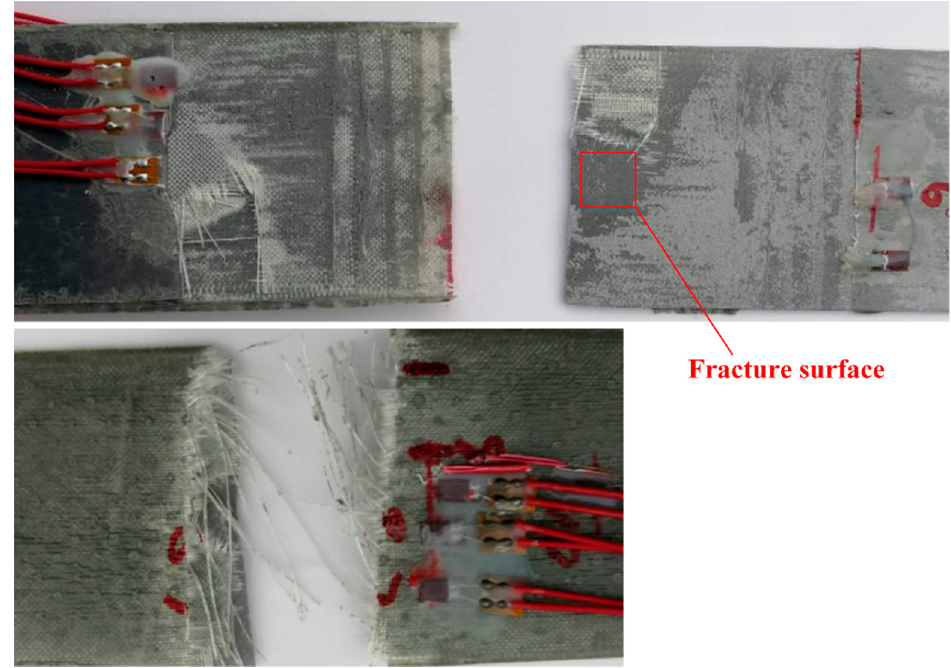
Figure 6. The visual examination of the fracture surface after the testing.